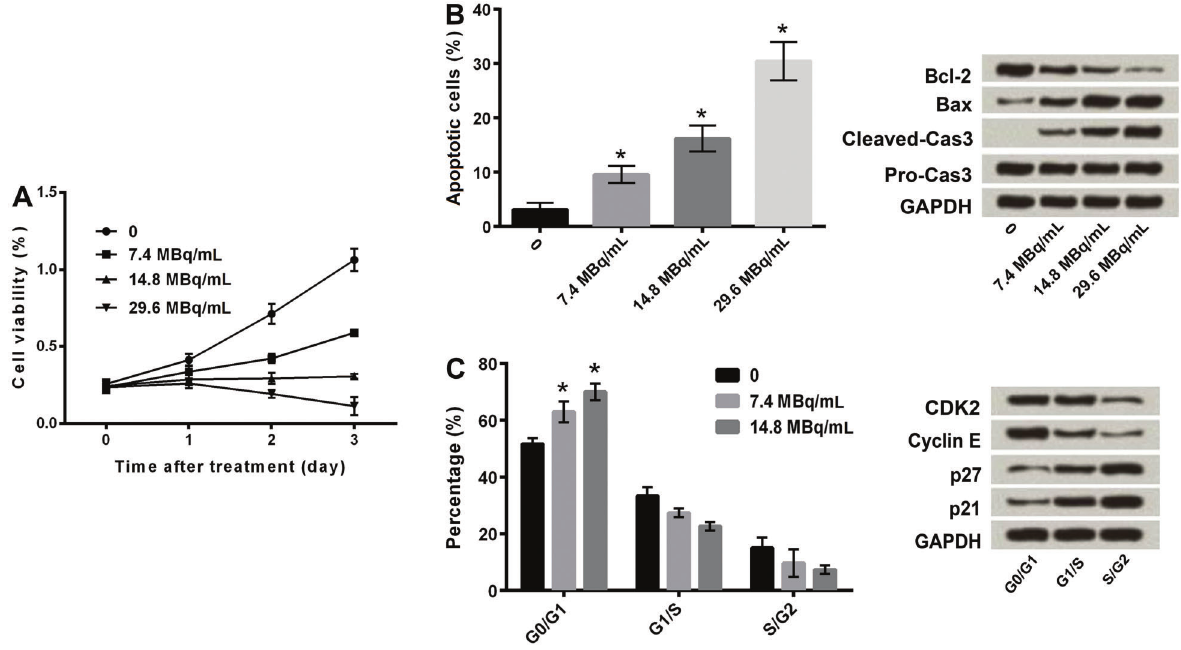
Figure 1. Effects of iodine-131 ( 131 I) on cell proliferation ( A ), cell apoptosis ( B ) by regulating apoptosis-related protein, and cell cycle arrest ( C ) by modulating cell cycle-related protein. Data are reported as means ± SD. *P o 0.05 compared with control (CTL – GAPDH)